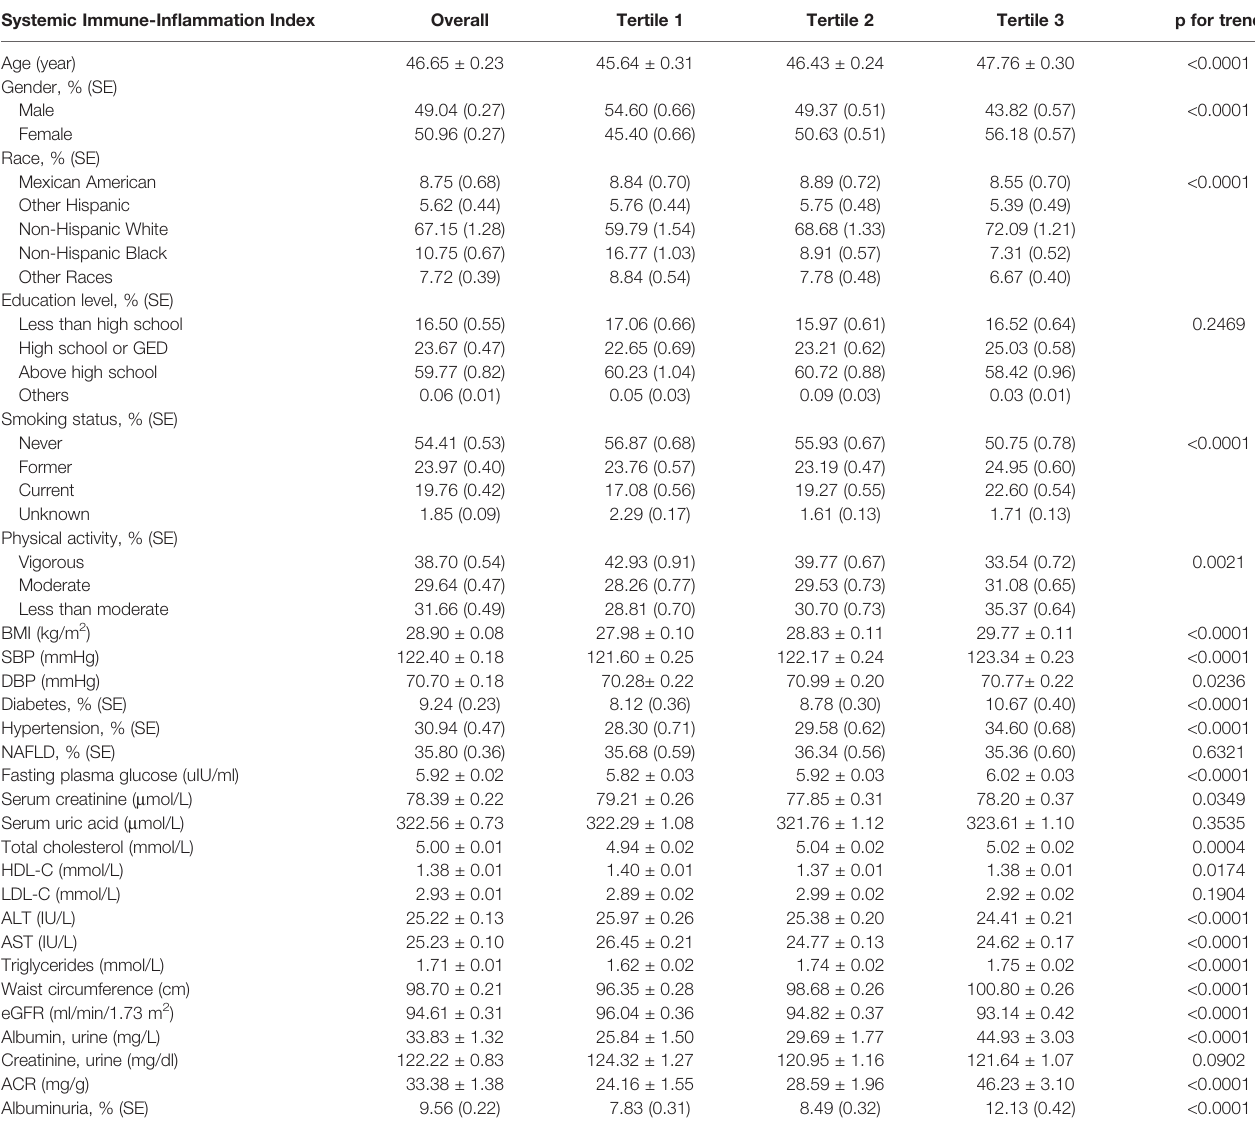
TABLE 1 | Baseline characteristics of study population according to systemic immune-in fl ammation index tertiles, weighted. Systemic Immune-In fl ammation Index Overall Tertile